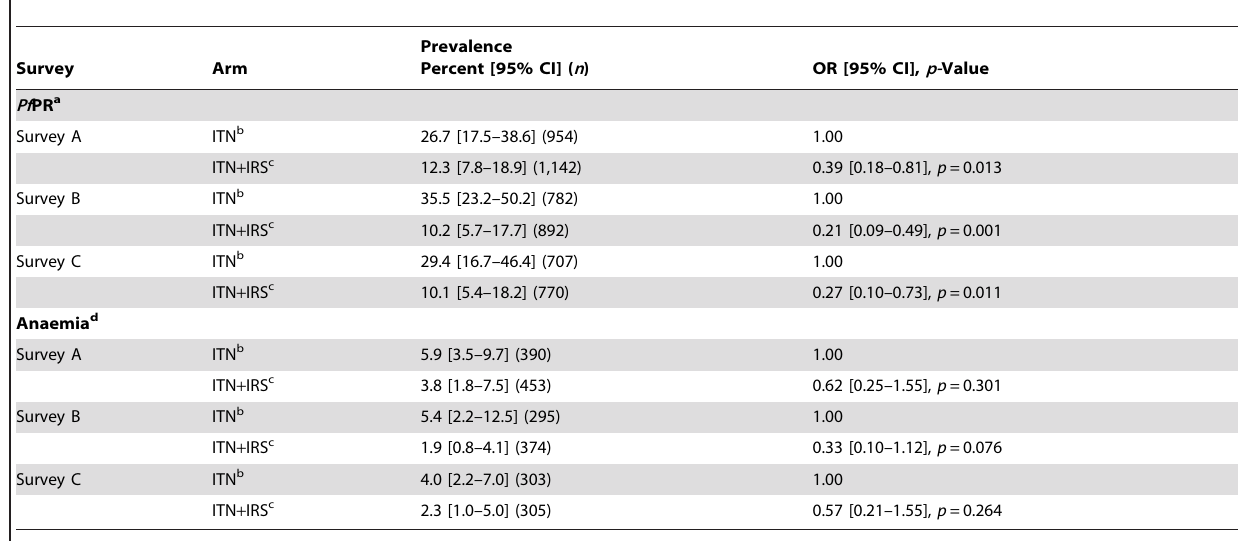
Table 7. Per-protocol analysis of Pf PR in children 0.5–14 y old and anaemia in children under 5 y old in surveys A, B, and C.